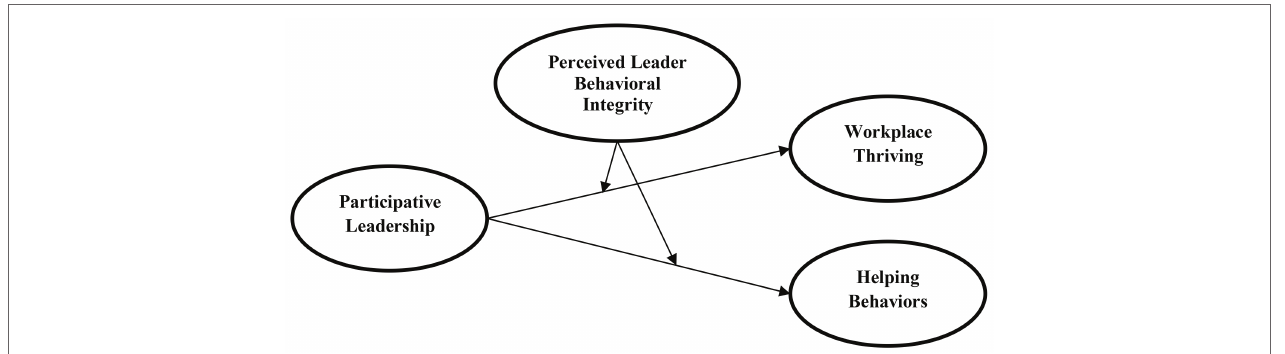
FIGURE 1 | Proposed model.